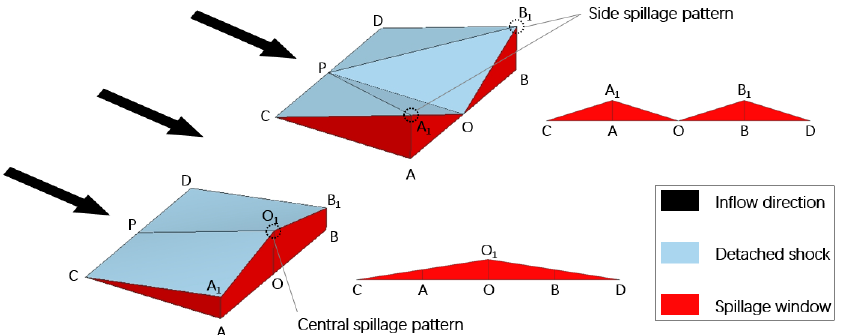
Figure 2. Modular assessments of two spillage patterns for bump inlet integration.